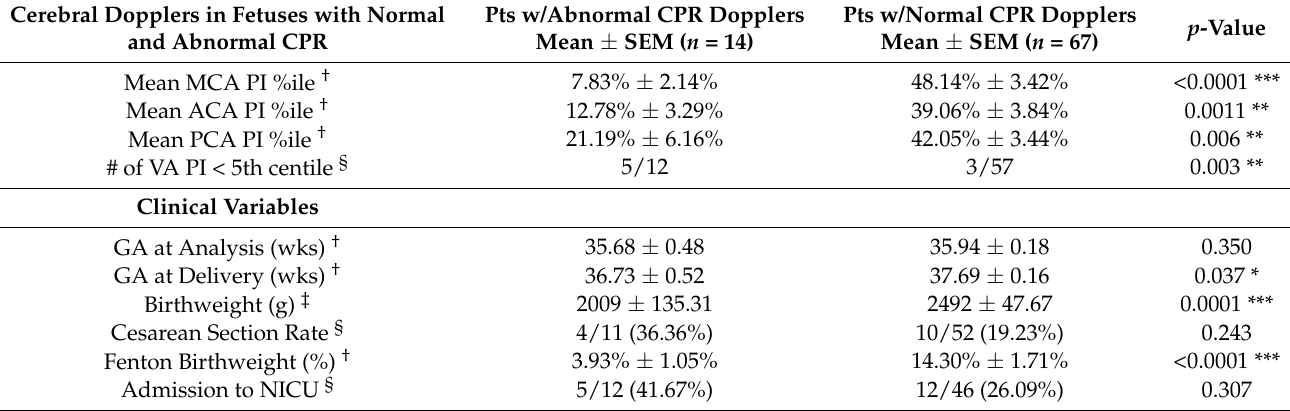
Table 5. Comparison of patient characteristics in fetuses with and without abnormal CPR (<5th